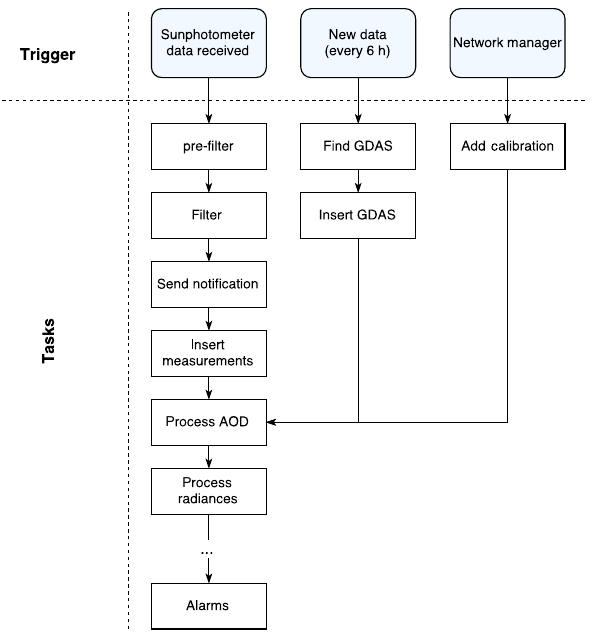
Figure 4. Different processing chains and their relationships. An action triggers a task and then the actions bubble